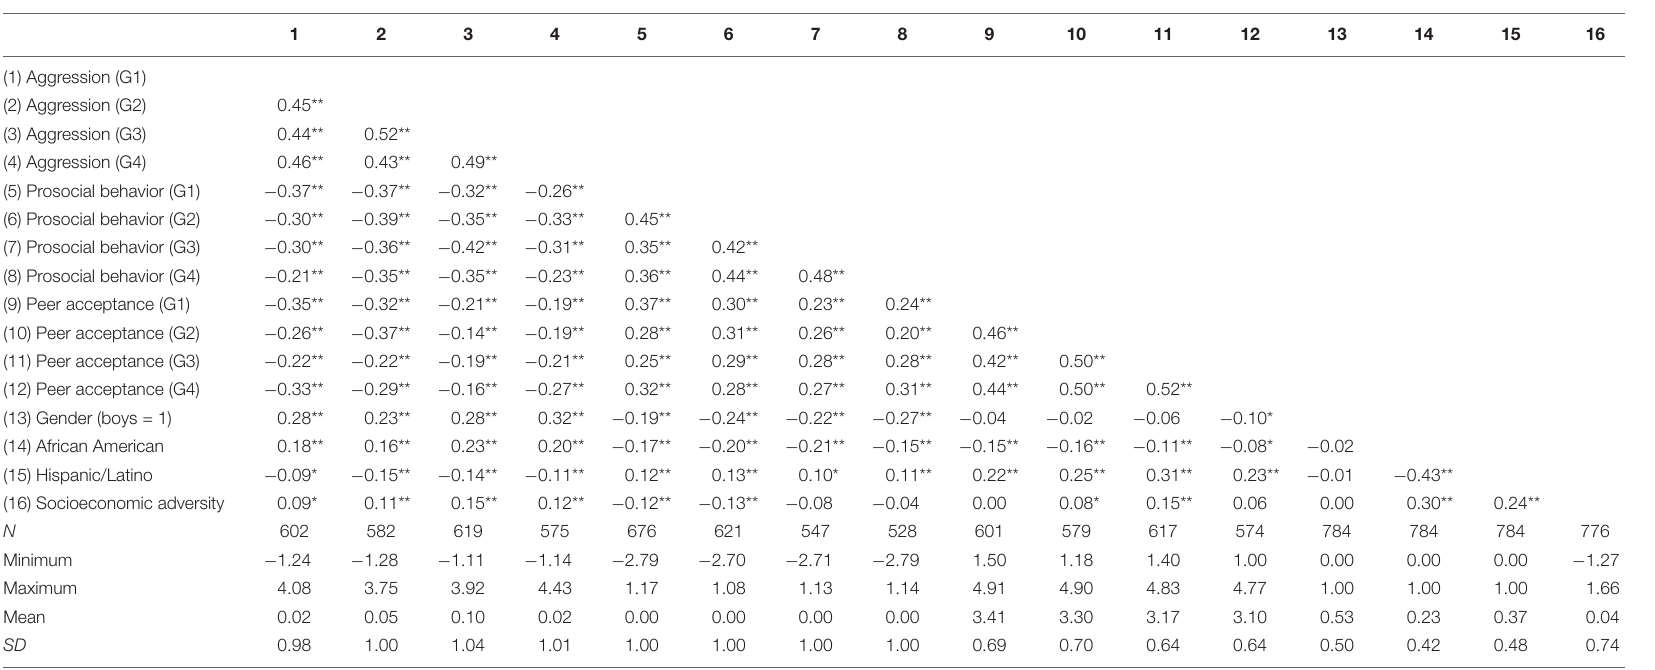
TABLE 1 | Bivariate correlations and descriptive statistics of study